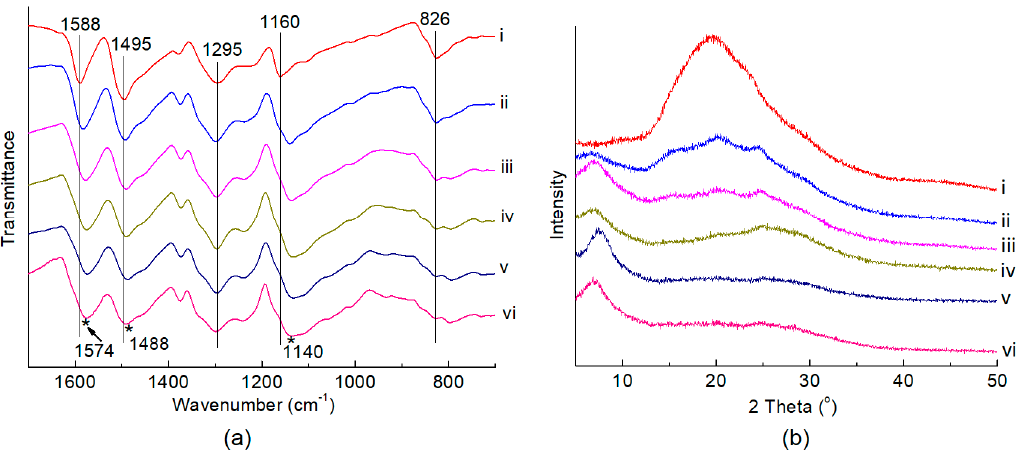
Figure 1. ( a ) FTIR spectra and ( b ) XRD patterns of the polyaniline (PAN) and x -PMo 12 / PAN catalysts. ( i ) PAN; ( ii ) 10 -PMo 12 / PAN; ( iii ) 20 -PMo 12 / PAN; ( iv ) 30 -PMo 12 / PAN; ( v ) 40 -PMo 12 / PAN; ( vi ) 50 -PMo 12 / PAN.